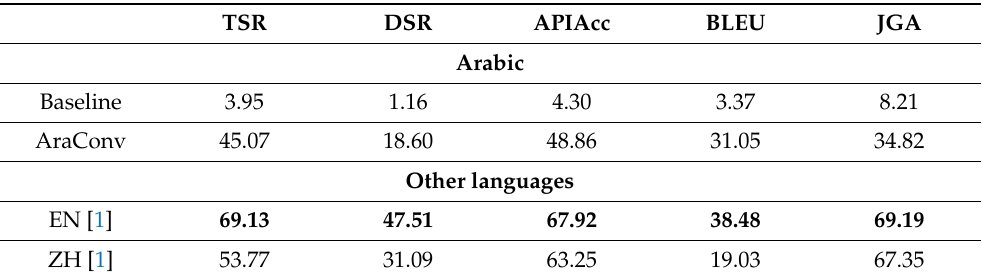
Table 4. Mono-lingual experiment dialogue state tracking (DST) and end-to-end dialogue generation results for the AraConv model trained on Arabic-TOD dataset compared to the baseline and the mono-lingual BiToD experiments [1] using English (EN) and Chinese (ZH). Bold numbers indicating the best result according to the column’s metric